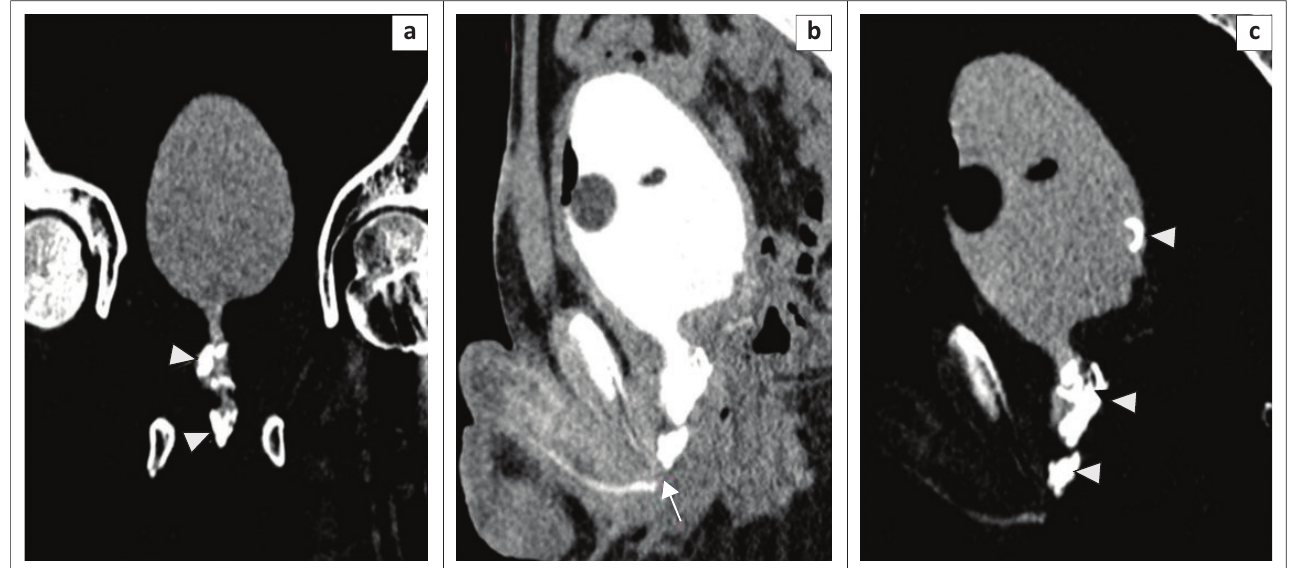
FIG URE 12: (a–c) A stricture at the bulbomembranous junction (arrow) with multiple smooth, tubular and linear hyperdensities noted in the posterior urethra (arrowheads) in all sections and also in the bladder in (c). Altering the window settings in (c), the hyperdensities not visible in (b) become markedly visible in (c). These were confirmed to be broken pieces of catheter with encrustations at surgery.